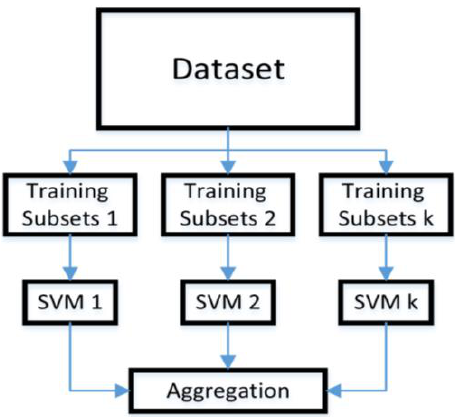
Figure 6. Support Vector Machine.